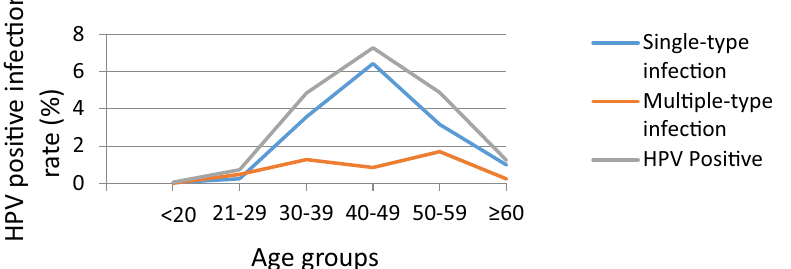
Figure 1. HPV infection rate in different age groups.